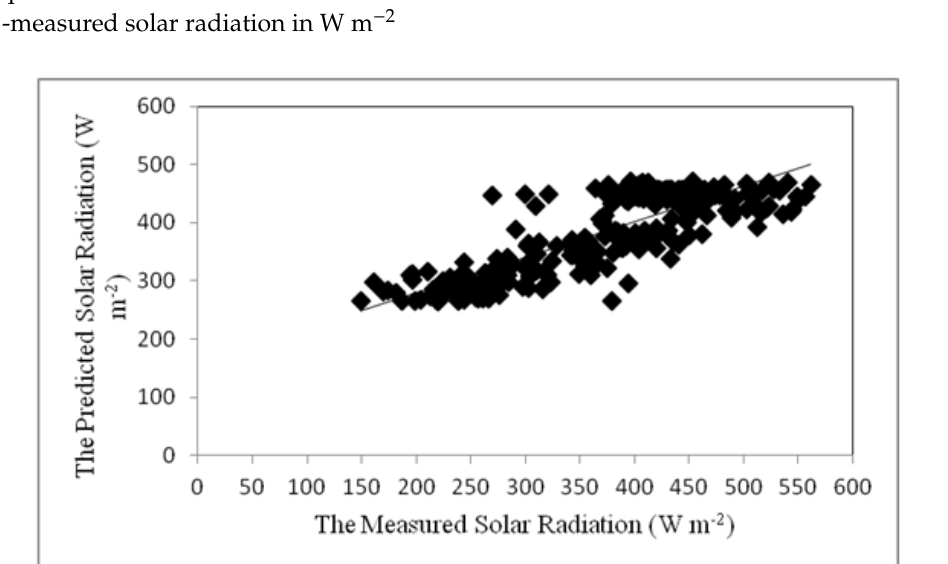
Figure 17. Comparison between predicted and measured solar radiation.